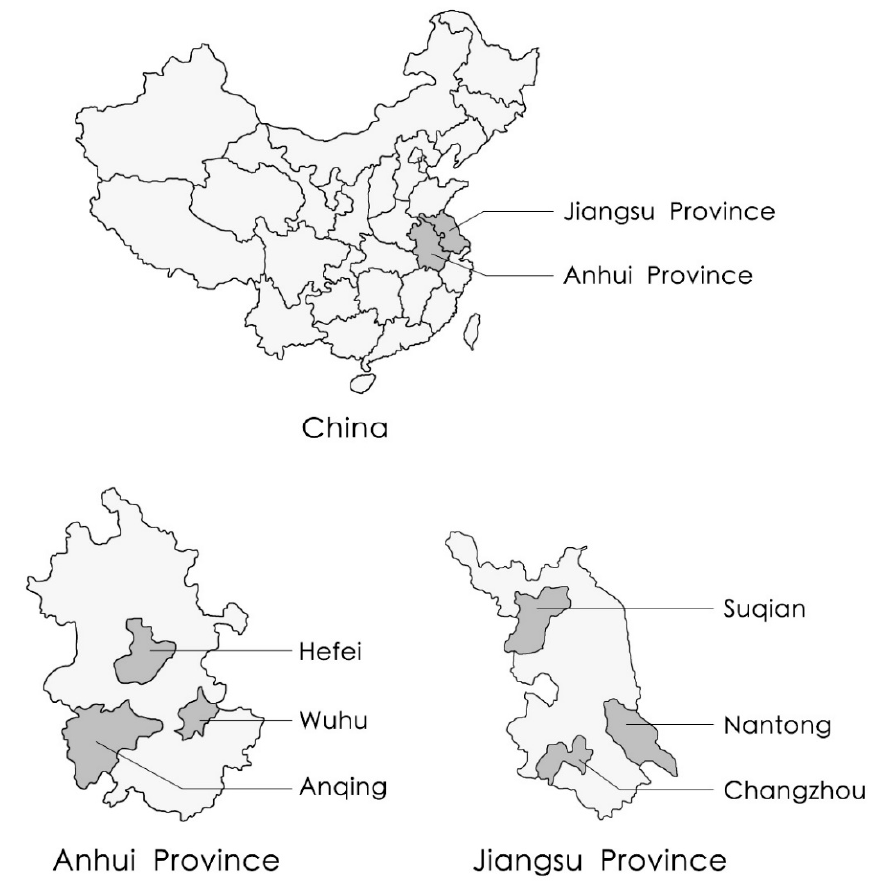
Figure 1. Map of the study areas in China.